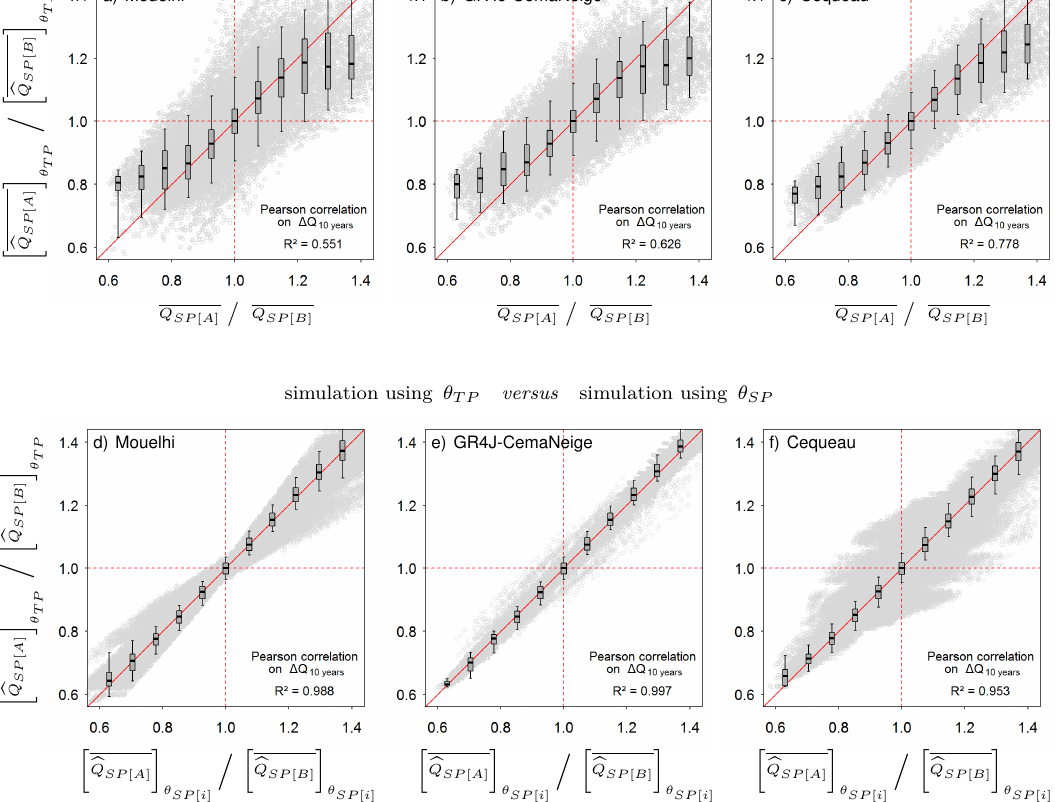
Fig. 9. Comparisons of relative changes in 10yr mean flow, observed and simulated (aggregation of results from 20 catchments, considering any possible pair of 10yr sub-periods A and B